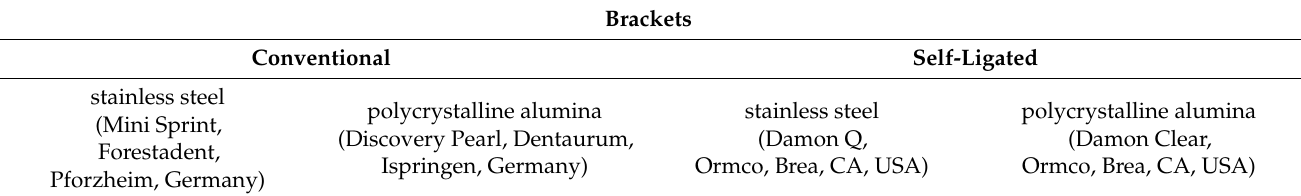
Table 1. Types of brackets included in the